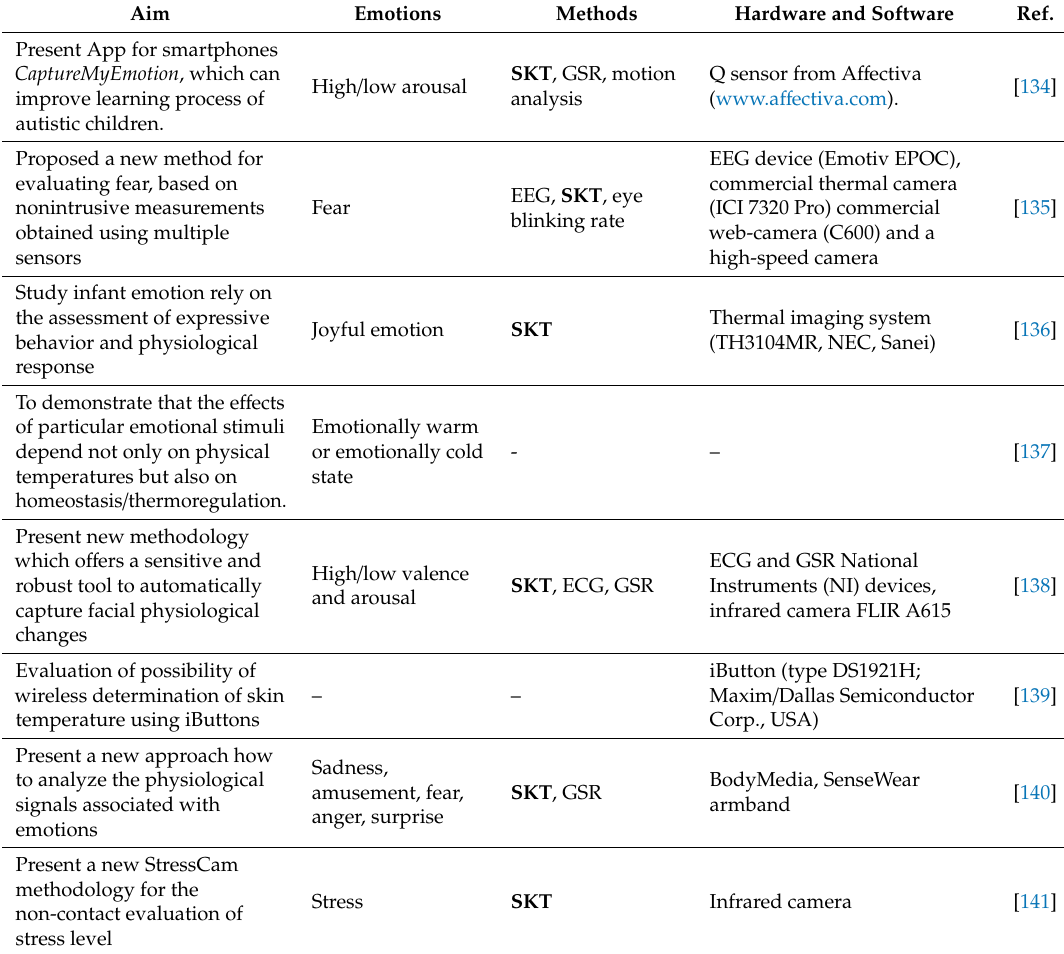
Table 8. Review of scientific researches focused on emotions recognition and evaluation using SKT. Aim Emotions Methods Hardware and Software Ref. SKT , GSR, motion High / low arousal